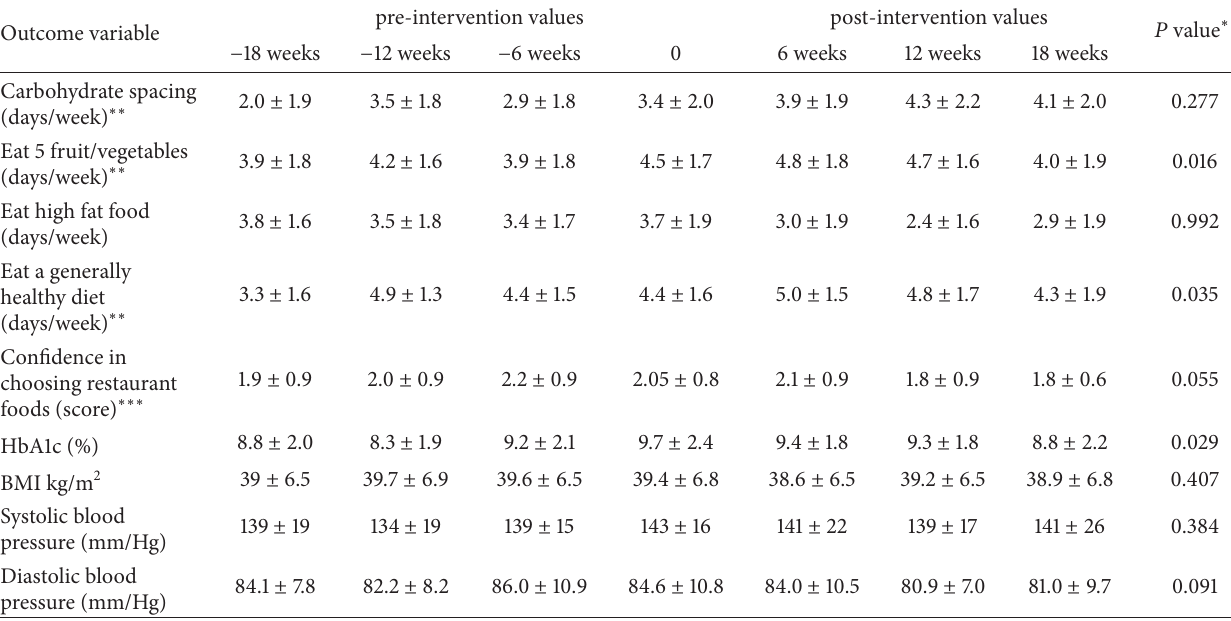
Table 3: Group medical nutrition therapy/motivational interviewing intervention among African American women with type 2 diabetes: impact on self-care, psychosocial, and physiologic outcomes. Outcome